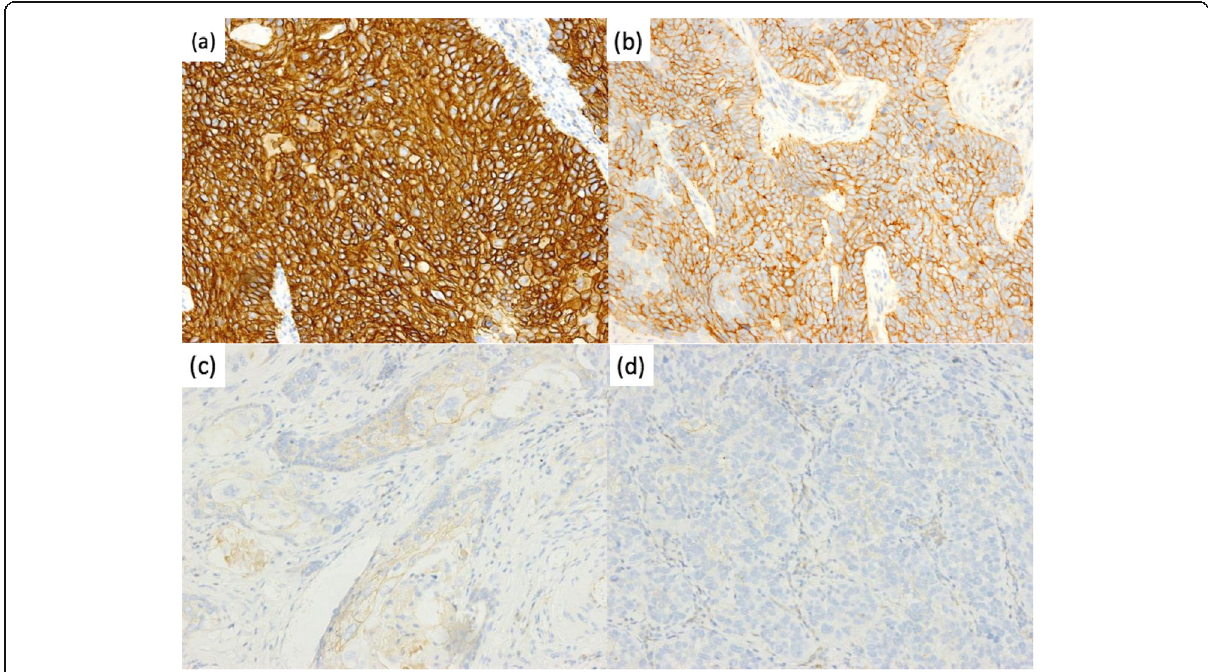
Fig. 1 Immunohistochemistry showing HER2 expression in esophageal squamous cell carcinoma. a HER2 overexpression in tumor cells. Original magnification, 200×. b HER2 equivocal expression in tumor cells. Original magnification, 200×. c , d HER2 negative expression in tumor cells. Original magnification, 200